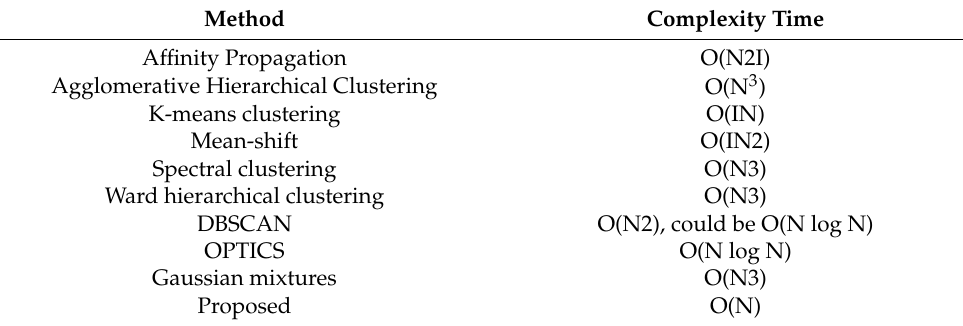
Table 1. The time complexity (Big O) for each clustering algorithm. Method Complexity Time Affinity Propagation O(N2I) Agglomerative Hierarchical Clustering O(N 3 )